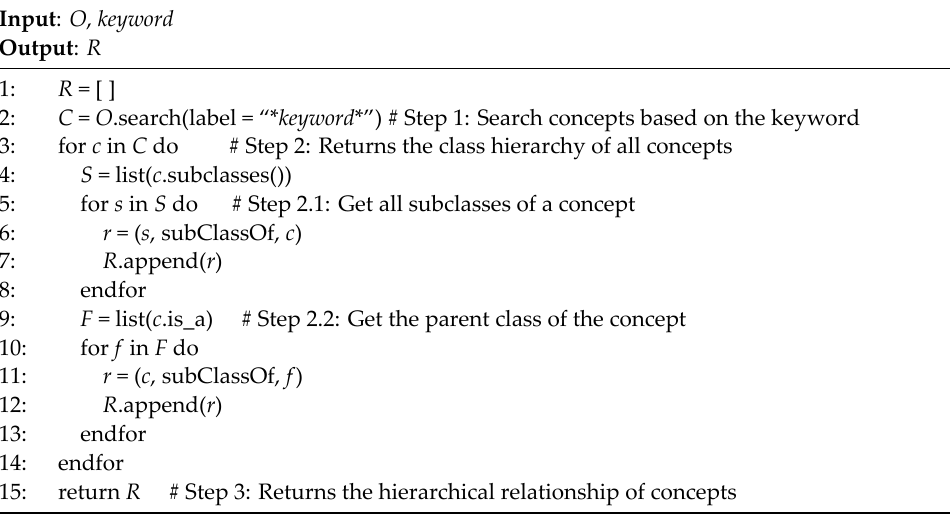
Algorithm 1. Ontology concept